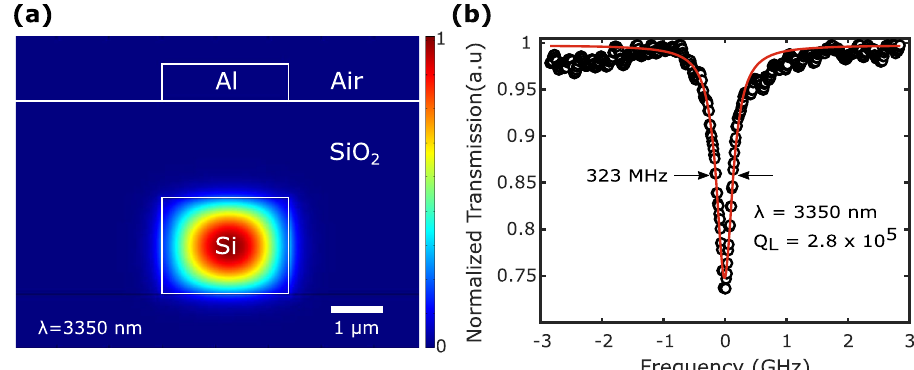
Fig. 2 Mode simulation and normalized transmission spectrum of the fundamental transverse electric (TE) mode at 3350 nm. a Finite Element Mode (FEM) simulation of the fundamental TE mode for a silicon waveguide (2000 nm height (H) × 2400 nm width (W)) with oxide cladding and aluminum (Al) heater on top for a 150 μ m bending radius. b Transmission spectrum of the microring at 3350 nm wavelength ( λ ) measured using a piezo controlled optical parametric oscillator (OPO) system. The measured linewidth is 323 MHz, corresponding to the loaded quality factor ( Q L ) of 2 : 8 ´ 10 5